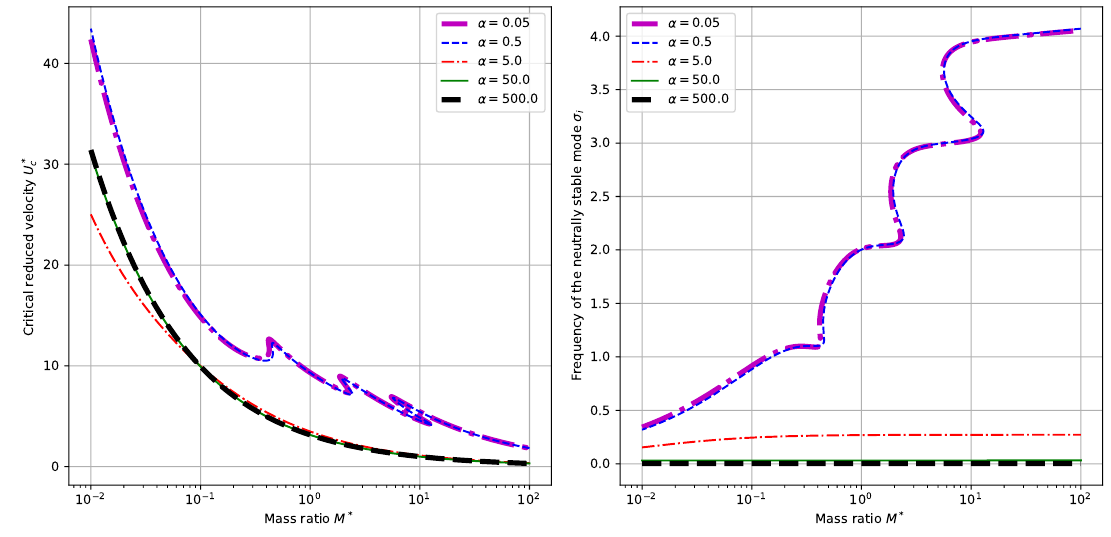
Figure 4. Dependence of the critical reduced velocity U ∗ c ( left panel) and the corresponding neutrally stable frequency σ i ( right panel) upon the mass ratio M ∗ and different values of α . (Here we have β =